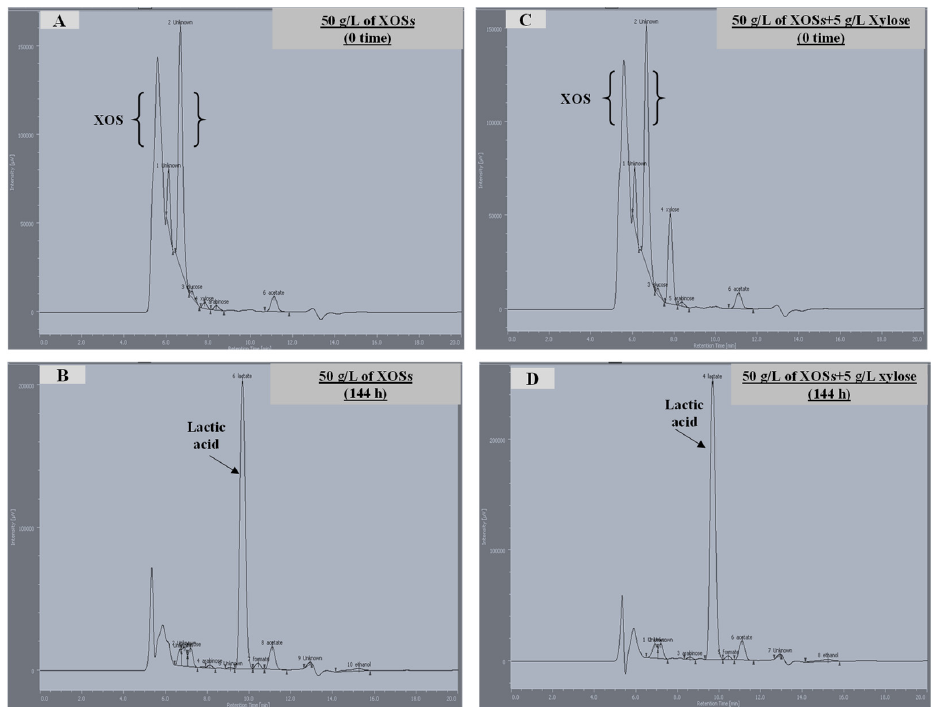
Figure 5. HPLC profiles of lactic acid fermentation by E. faecium s6 in mMR broth supplemented with XOS ( A , B ) and xylose/XOs mixture ( C , D ) as carbon source. Fermentation times: ( A , C ) 0 h, ( B , D ) 144 h.